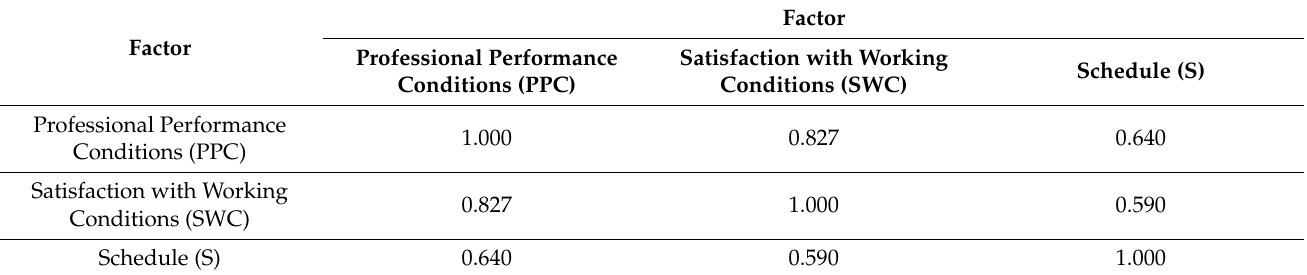
Table 6. Factor Correlation Matrix.